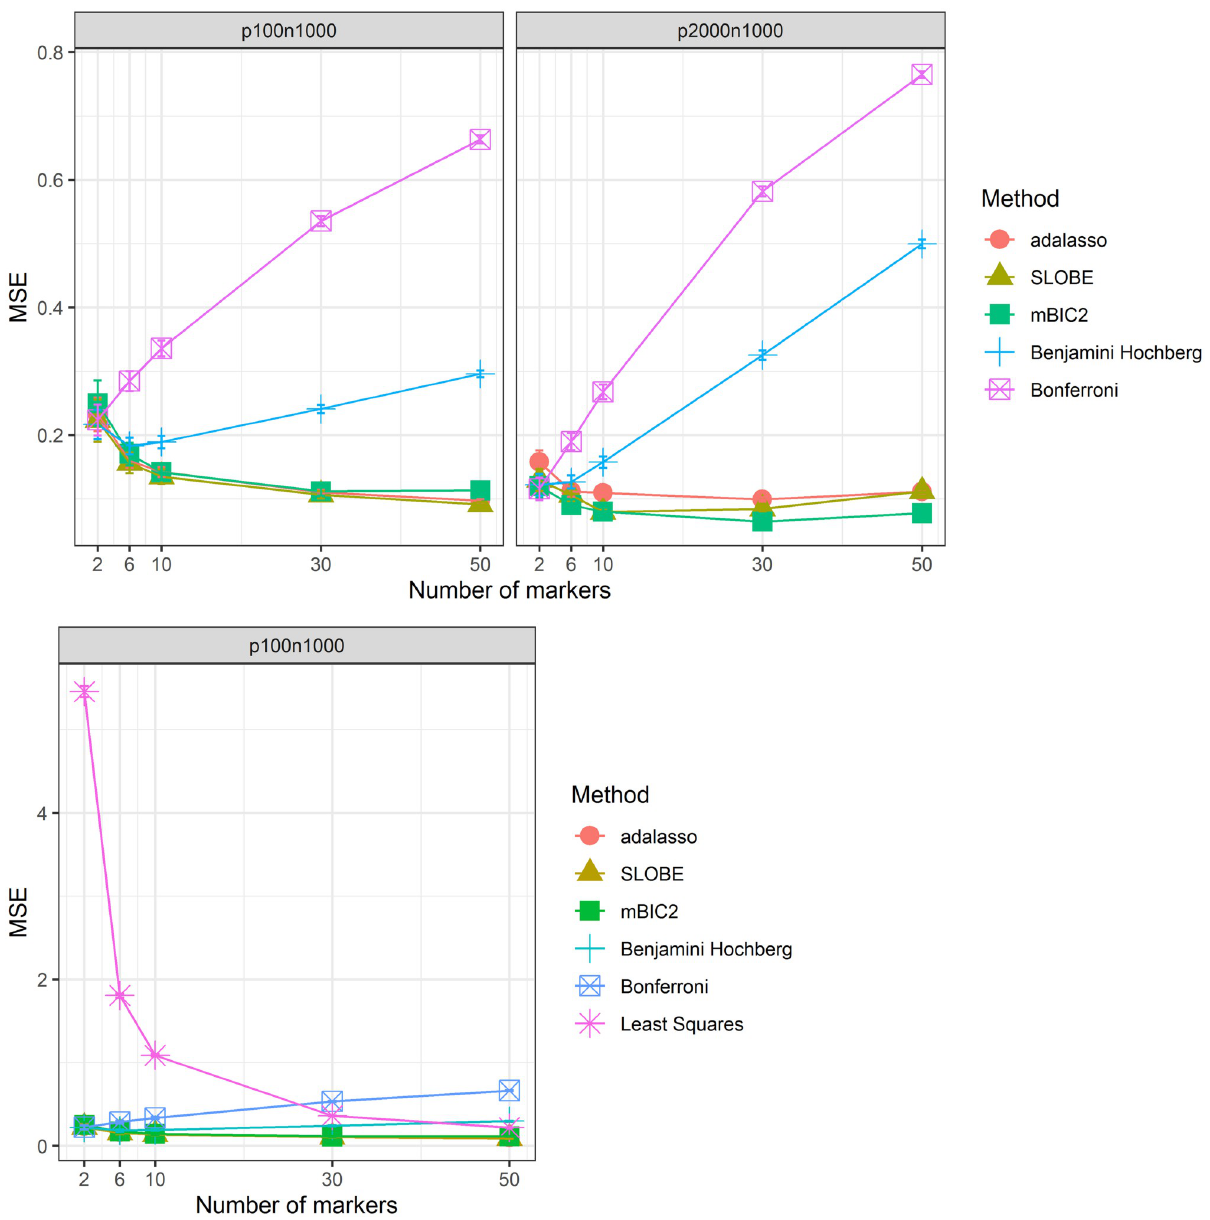
Fig 2. Estimation of predictive index. Mean Squared Error of the estimated predictive index R ( X ) as a function of the number of causal variants k for two different simulation scenarios ( p < n and p > n ). The last panel includes MSE for the ordinary least squares estimate (LSE).